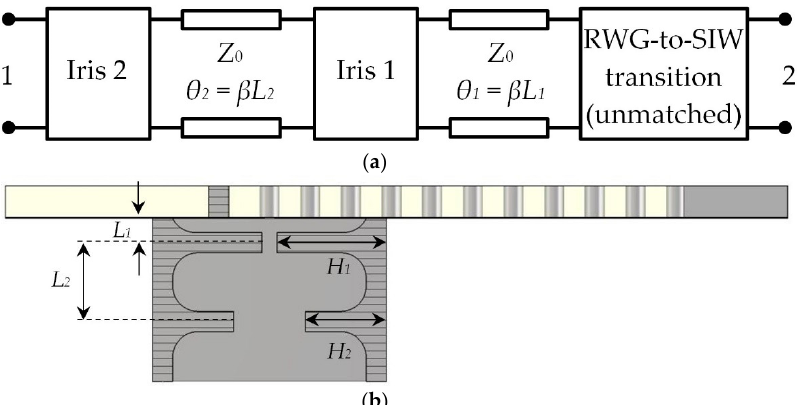
Figure 7. Two-section matching network. ( a ) Equivalent circuit; ( b ) Physical implementation.